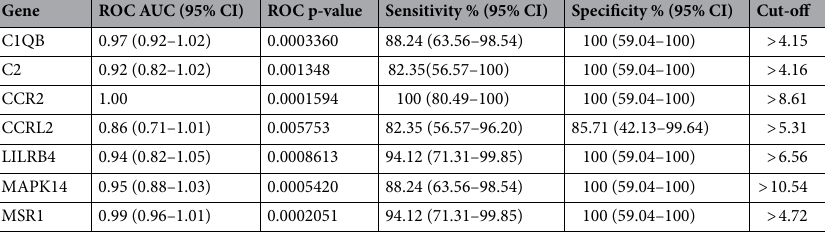
Table 3. ROC analysis, sensibility and specificity of candidate genes to predict TB